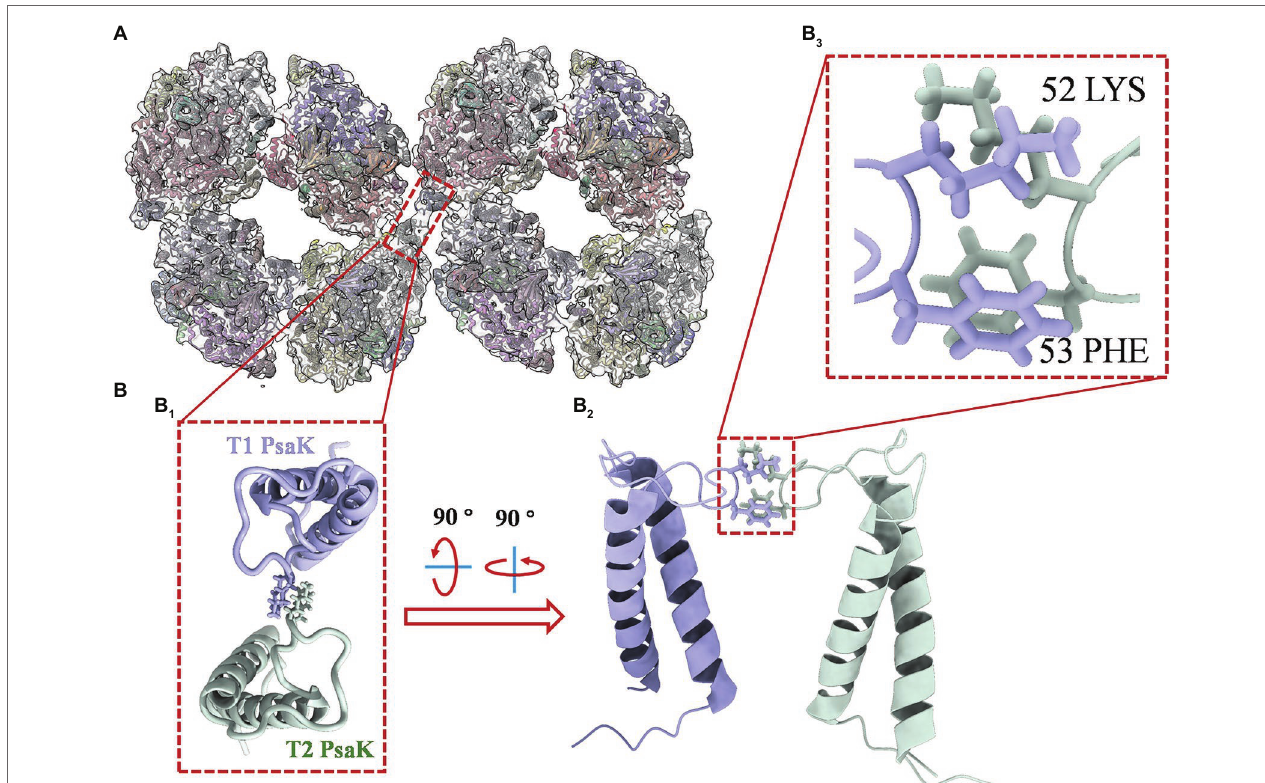
FIGURE 3 | Structure details of PsaK-PsaK interaction in PSI octamer supercomplex. (A) Overall view of the interface location in the complex (top view from the stromal side). The original structure applied for fitting is the PSI tetramer model (PDB code: 6TCL) from Anabaena sp. PCC 7120. (B) Close-up view of structural details indicated in (B 1 ) . The enlarged top view of two PsaK subunits from the assembled PSI tetramers (T1 and T2), the interacted amino acids were shown as stick form. (B 2 ) Tilted side view of interacted PsaK subunits. (B 3 ) The focus view of intact amino acids Lys52 and Phe53 in PsaK